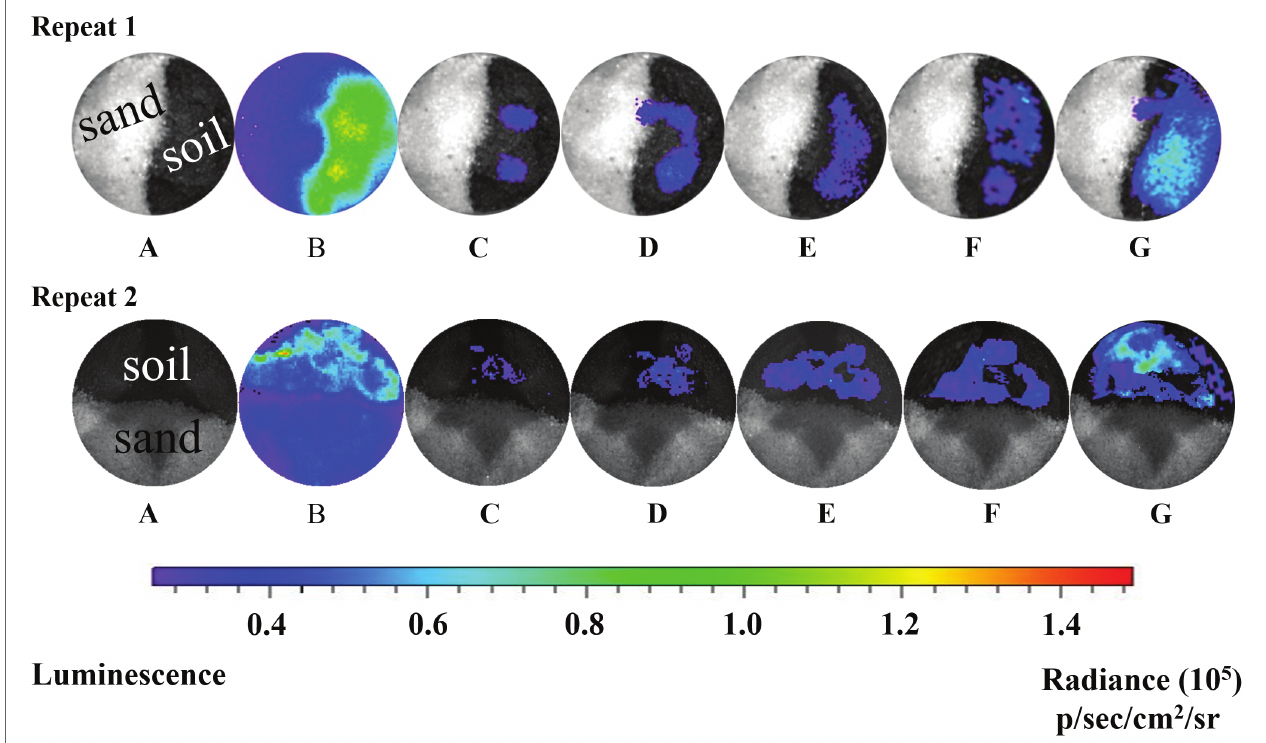
FIGURE 2 | Bioluminescent images of the distribution of Pf 5RL in a sand and soil cross-section during co-transport with naphthalene and after elution. Images represent a series of two independent experiments. A: zero time point image of the sand and soil cross-section saturated with naphthalene and injected with Pf 5RL. B: 4-h time point of same cross-sectional area shows high levels of bioluminescence being produced by Pf 5RL due to exposure to naphthalene. C: image acquired after eluting the cross-section area with background solution to flush out naphthalene. Bioluminescent signal indicates that Pf 5RL cells have been retained within the soil interface. D, E, F: images of cross-section area 1, 2, and 3 h respectively after the termination of the background solution flushing event. G: image of cross- section area after re-introduction of nine pore volumes of a naphthalene-free suspension of Pf 5RL cells. p/s/cm 2 /sr: photon/s/cm 2